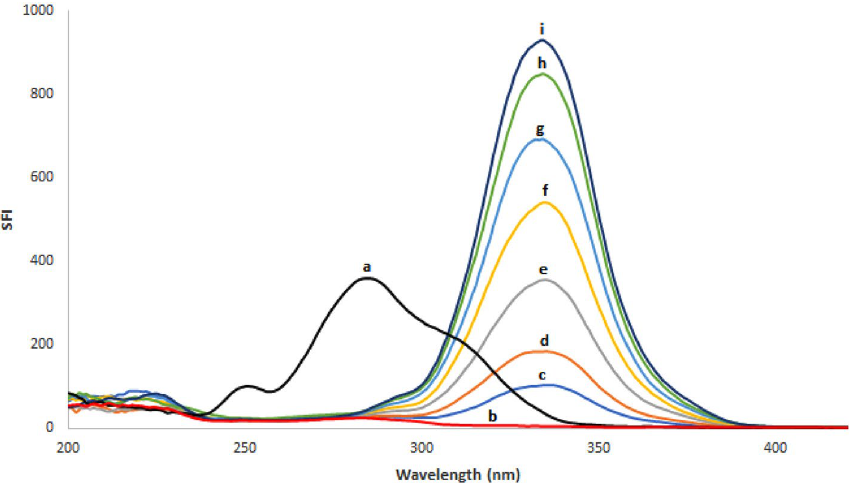
Figure 5. Synchronous fluorescence spectra of (a) REM (0.40 μg/mL), (b) Blank and (c-i: 0.10, 0.20, 0.40, 0.60, 0.80, 1.00, 1.10 μg/mL) of SIM at Δλ = 90